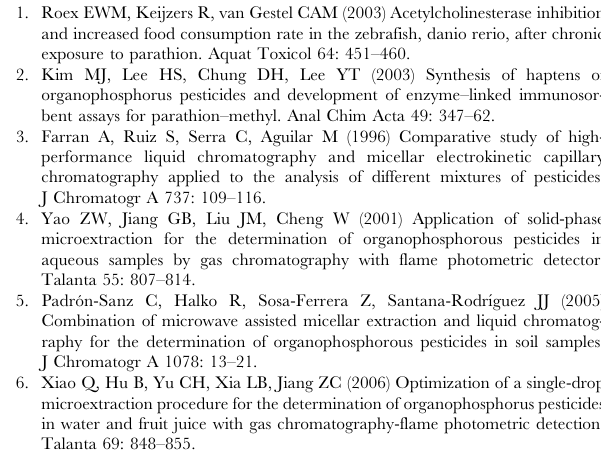
Figure S2 Effects of ionic strength on ELSIA. Each point on the y axis represents the mean IC 50 of parathion-methyl, parathion, and fenitrothion, and the x axis values are the concentration of NaCl (n =3). (TIF) Figure S3 Effects of pH value on ELSIA. Each point on the y axis represents the mean IC 50 of parathion-methyl, parathion, and fenitrothion, and the x axis values are pH values of the solution (n= 3). (TIF) Table S1 Effects of antigens on the gold immunochromato- graphic assay (n= 3). Table S2 Comparison of difference NC membrane on sensitiv- ity, test time, and T line color. Table S3 Effects of ionic strength on the gold immunochroma- tographic assay (n= 3). Table S4 Effects of pH values on the gold immunochromato- graphic assay (n= 3). Table S5 Effects of Triton x-100 on the immunochromato- graphic assay (n= 3). Table S6 Effects of PEG 20000 on the immunochromato- graphic assay (n=